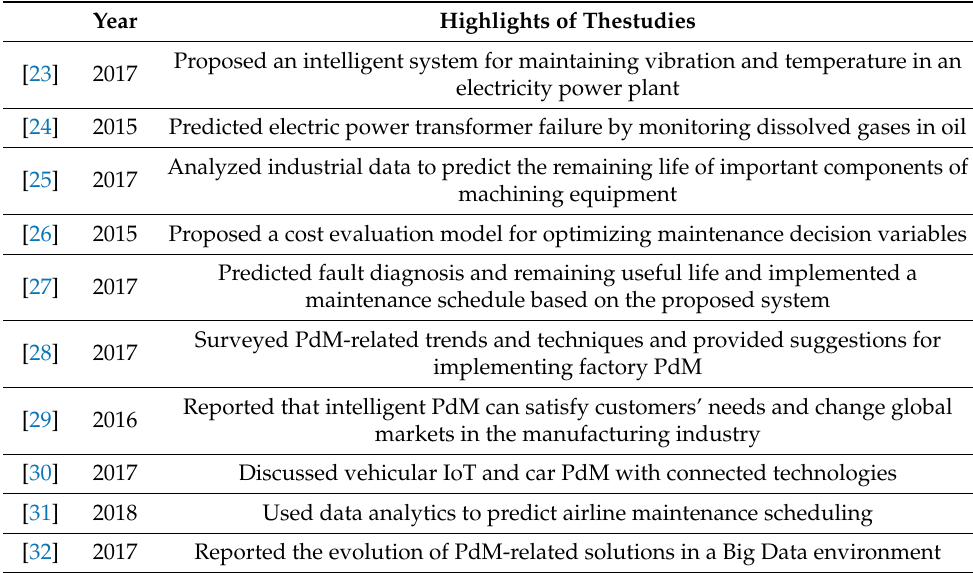
Table 1. Highly cited PdM-related